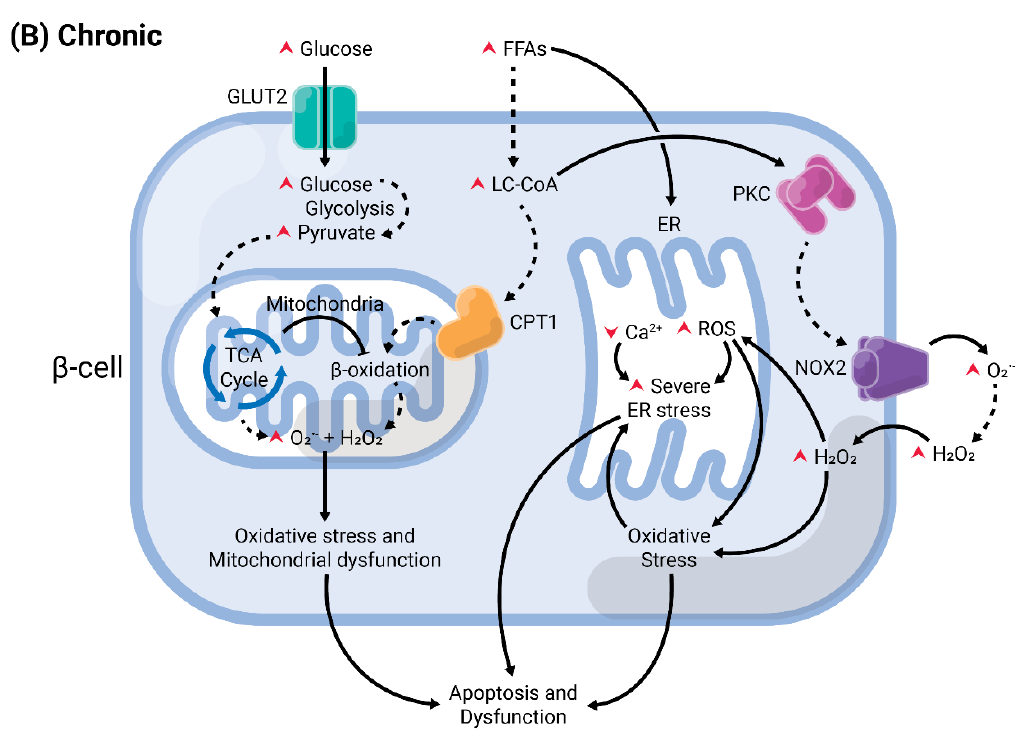
Figure 4. Summary of acute versus chronic effects of fatty acids (FAs) in pancreatic β -cells. Glucose enters the β -cell through specific transporters located at the plasma membrane, GLUT2 (in rodents). After its phosphorylation by glucokinase, it undergoes various modifications by enzymes from the glycolysis, until the generation of pyruvate. This enters the mitochondria and is oxidized in the tricarboxylic acid (TCA) cycle. The electrons are transferred to the electron transport chain, resulting in the generation of reactive oxygen species (ROS), as byproducts, and ATP. ( A ) In acute conditions, FAs enter the cells and are converted into long-chain fatty-acyl CoA (LC-CoA), which is translocated to the mitochondria via carnitine palmitoyltransferase 1 (CPT1) to be oxidized in the β -oxidation, generating ATP and ROS. The increase of ATP/ADP leads to the closure of K + channels sensitive to ATP (K ATP ) at the plasma membrane. The consequent membrane depolarization leads to the opening of L-type voltage-gated Ca 2+ channels (L-VGCC). The rapid Ca 2+ influx mobilizes insulin granules, which are released. Long-chain saturated or unsaturated FAs can also bind to G α q-protein coupled receptor GPR40 at the plasma membrane. This activates the phospholipase C (PLC)/diacylglycerol (DAG) pathway, which respectively activates PKC and mobilizes Ca 2+ from the endoplasmic reticulum (ER), potentiating GSIS. Activation of PKC may also activate NADPH oxidase 2 (NOX2) at the plasma to produce ROS, which are second messengers for GSIS. ( B ) Chronic exposure to FAs leads to depletion of ER Ca 2+ and activation of ER stress, and potentiates ROS formation in all compartments (cytosol, mitochondria, and ER). Prolonged and unresolved oxidative stress, ER stress, and mitochondrial dysfunction culminate in apoptosis and